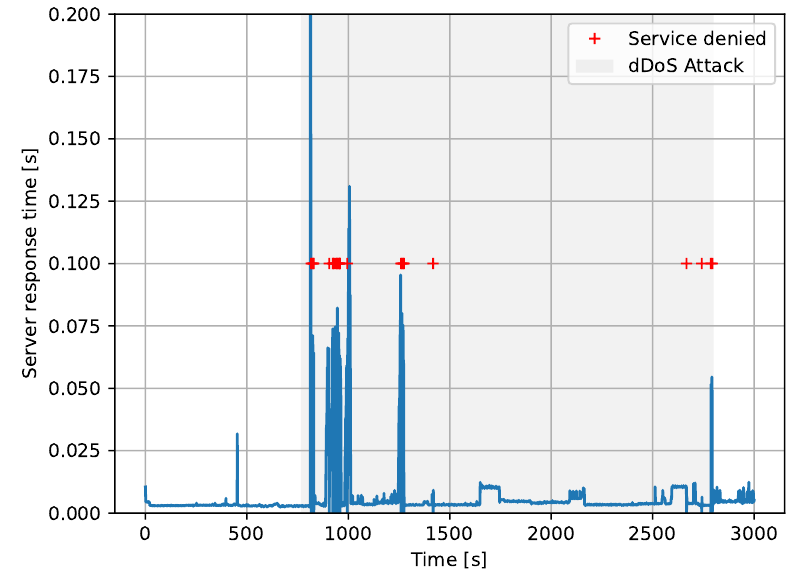
Figure 8. Autopolicy disabled. Grey area shows when the attack took place. Blue line shows the response time as seen from the user to the Service Provider. Red crosses are denied (timeout)